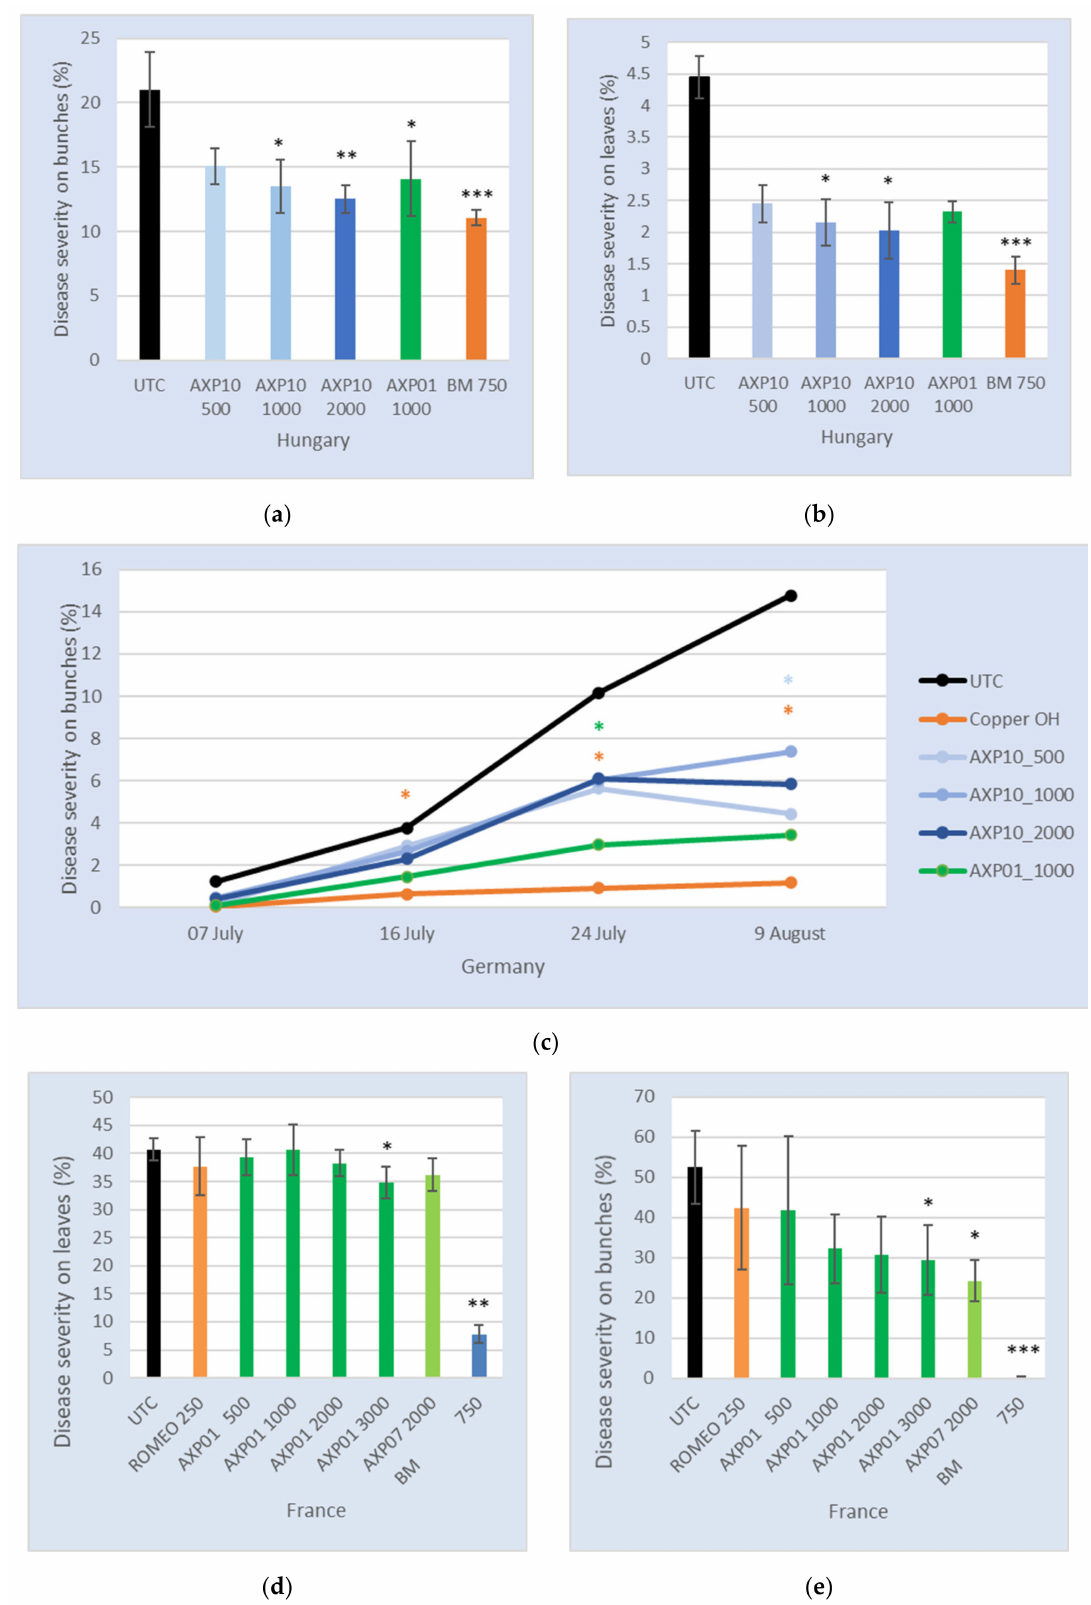
Figure 4. Field tests: Disease severity evaluated on the leaves ( a ) and the bunches ( b ) in a field trial conducted in Hungary. The black represents the untreated control; the increasing color intensities of blue correspond to increasing AXP10 concentrations from 500 to 2000 g AS / ha; the green represents